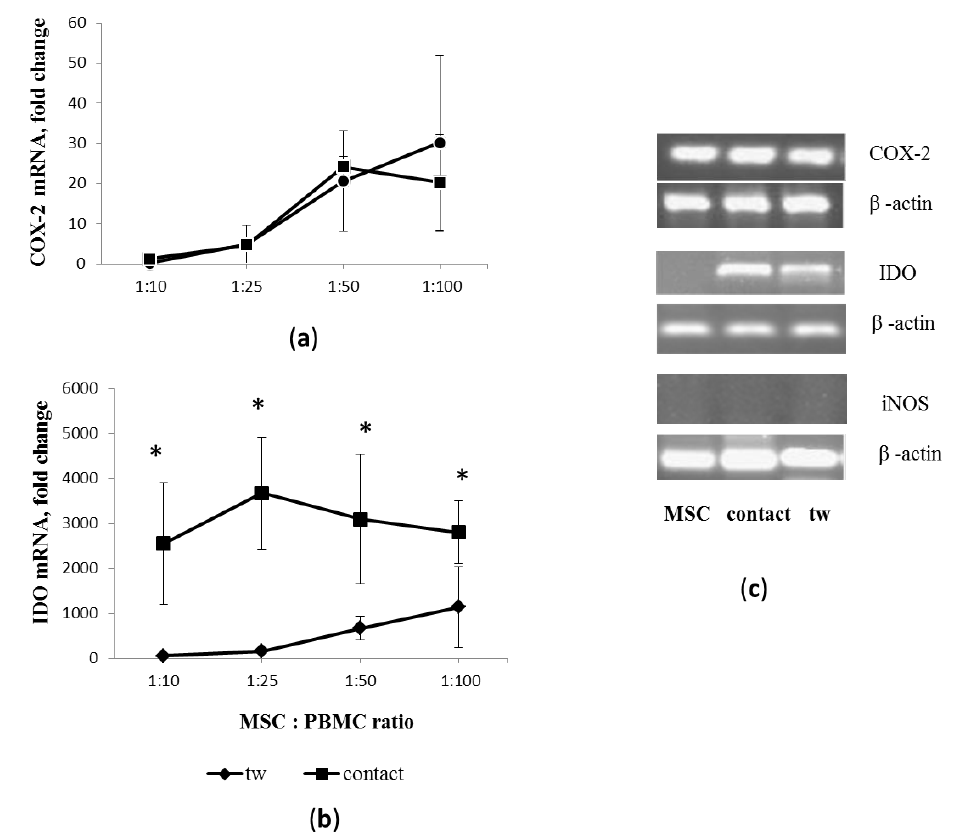
Figure 3. COX-2, IDO, and iNOS expression in MSCs in contact and non-contact (tw) co-culture with PHA-activated PBMCs. ( a , b ) Relative changes in COX-2 and IDO expression; mean values and their errors from 3 independent experiments are presented. MSCs were isolated from 3 unrelated donors. * reliability of differences at p < 0.05. ( c ) Representative electropherograms of PCR